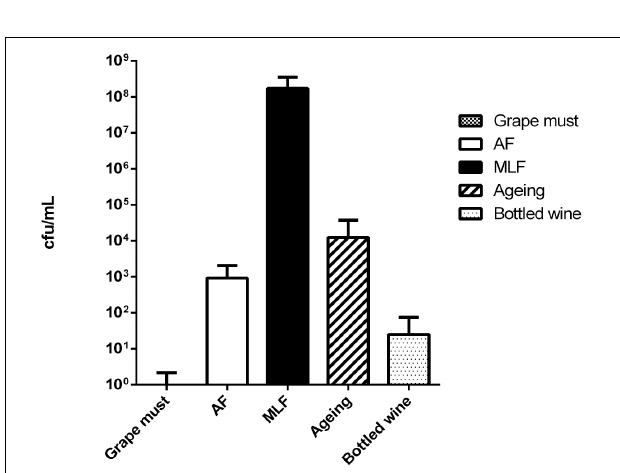
FIGURE 6 | Results of the O. oeni quantification by Cells-qLAMP of different grape musts and wines, both whites and reds, sampled at different winemaking stages. (Grape must) initial phases; (AF) during alcoholic fermentation; (MLF) during malolactic fermentation; (aging) during the aging in barrels; (bottled wine) final wines already